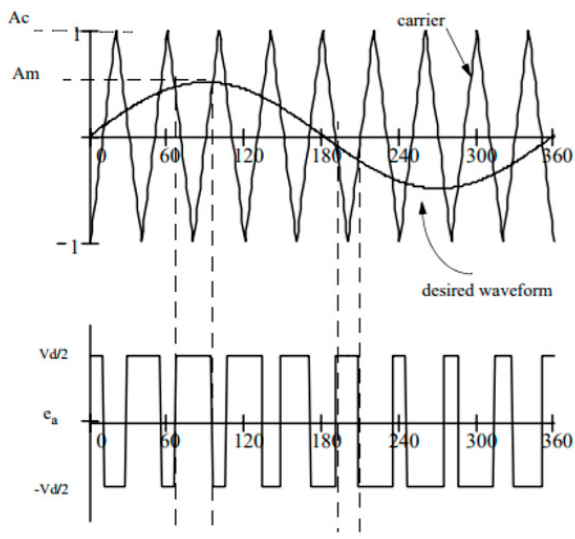
Figure 17. Working principle of Sinusoidal pulse width modulation (SPWM) [14].